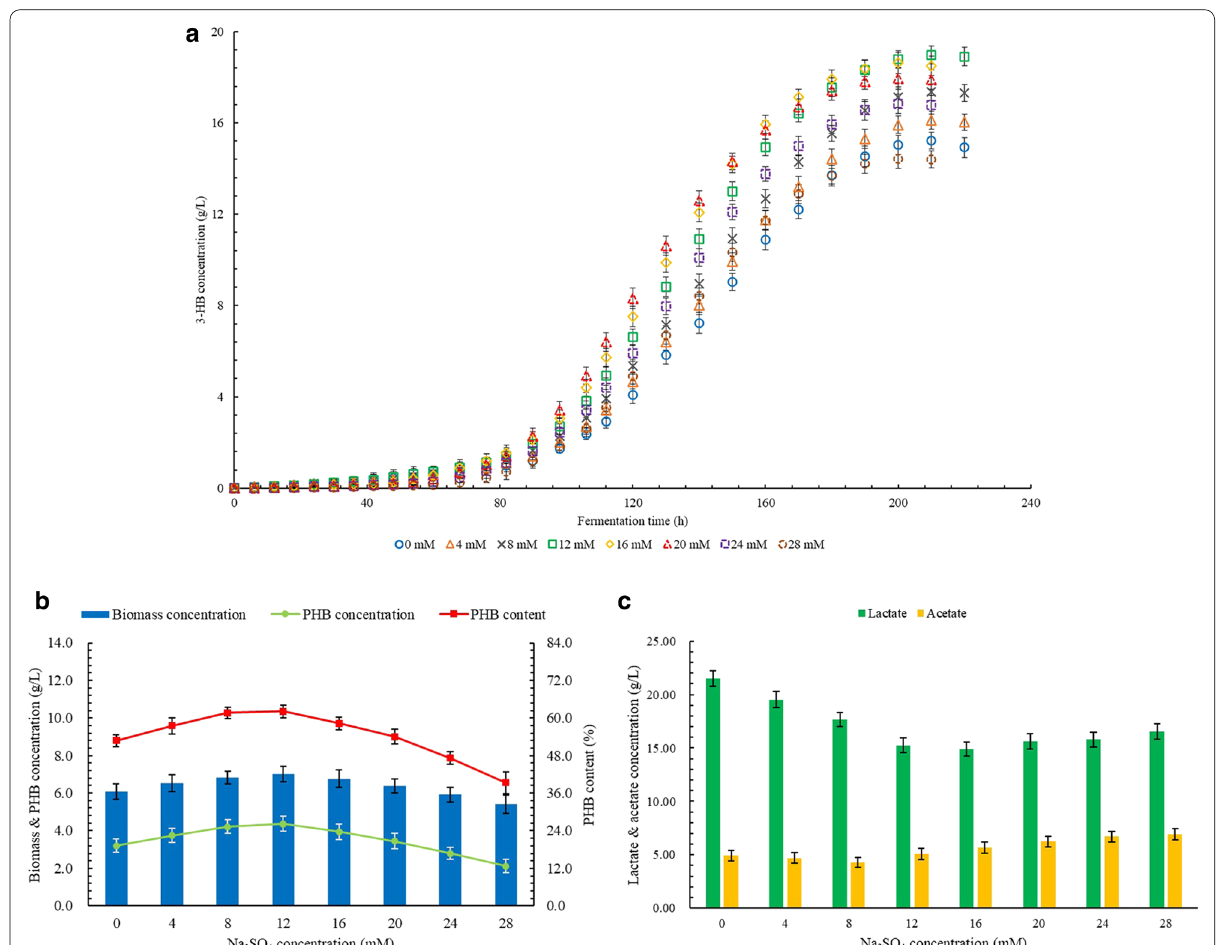
Fig. 2 a Effects of Na2SO4 on the production of 3-HB. b Effects of Na2SO4 on the production of PHB. c Effects of Na2SO4 on the production of LA and AC